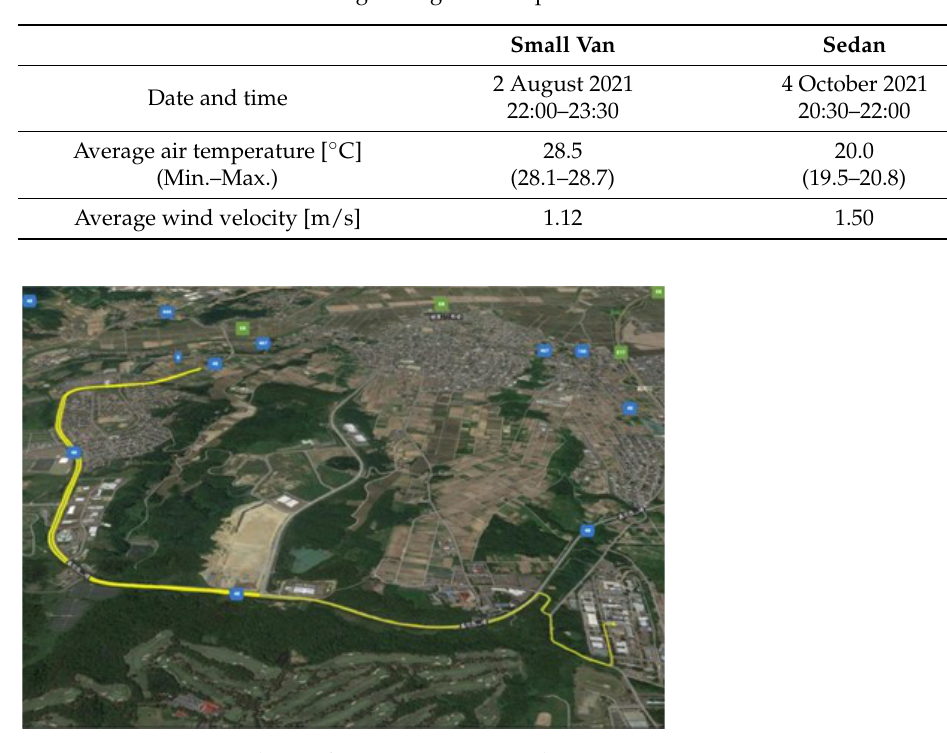
Figure 2. Heat flux sensors and other sensors on the vehicle roof: small van ( top ), sedan ( bottom ). Table 2. Weather conditions during the nighttime experiments.